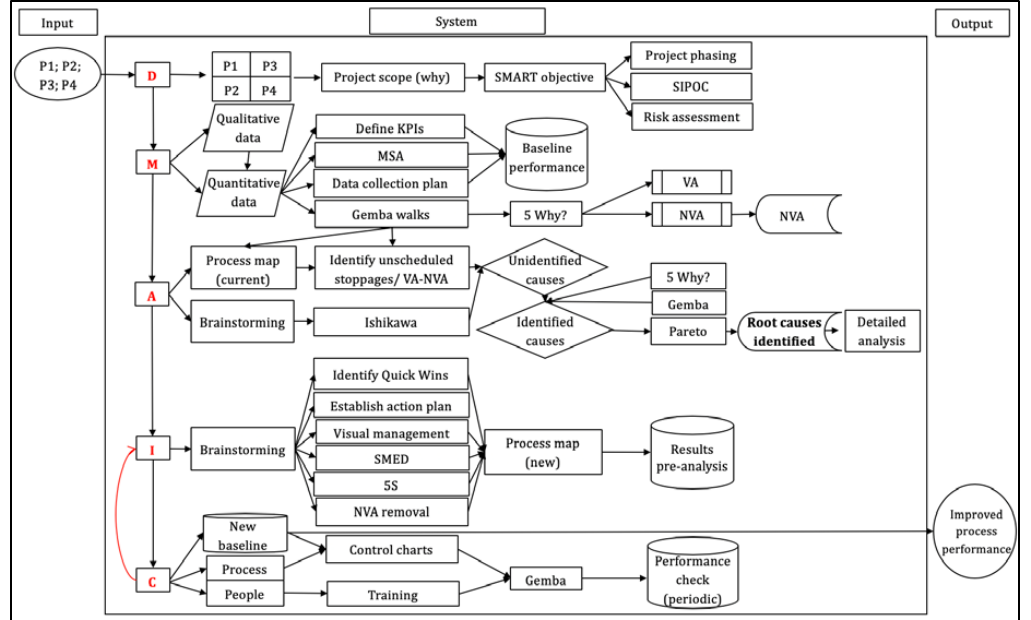
Figure 1. The Lean Six Sigma algorithm.